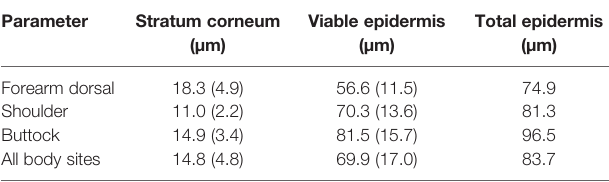
TABLE 4 | The thickness of stratum corneum and viable epidermis at different body sites — mean (standard deviation).